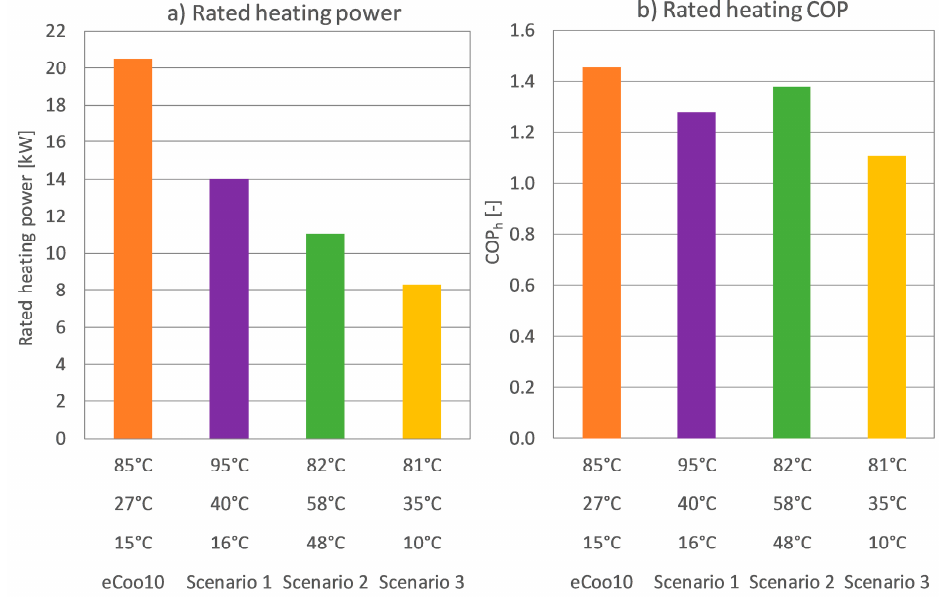
Figure 9. Experimental results at nominal flow rates of the eCoo10 for the heating application scenarios (1–3), a) Rated heating power and b) the rated COP for heating.